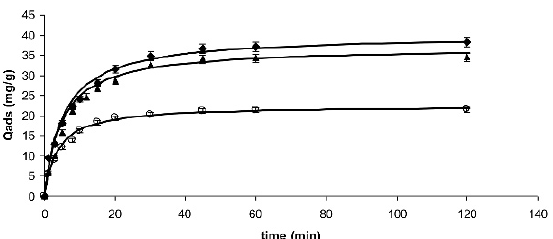
Figure 5. The adsorption kinetics of phenol with the initial concen- tration of 1 g/L over HBEA ( (cid:7) ), HFAU ( (cid:78) ) and HMOR (O). Solid line represents the simulation data based on the pseudo second-order adsorption